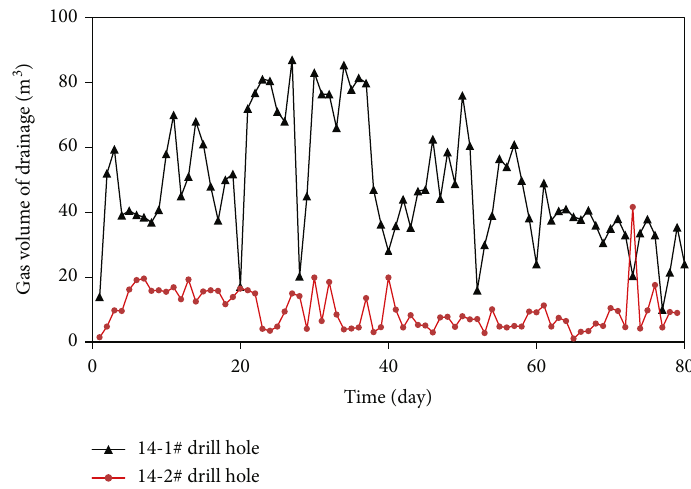
Figure 19: Gas extraction in the borehole group 14#.